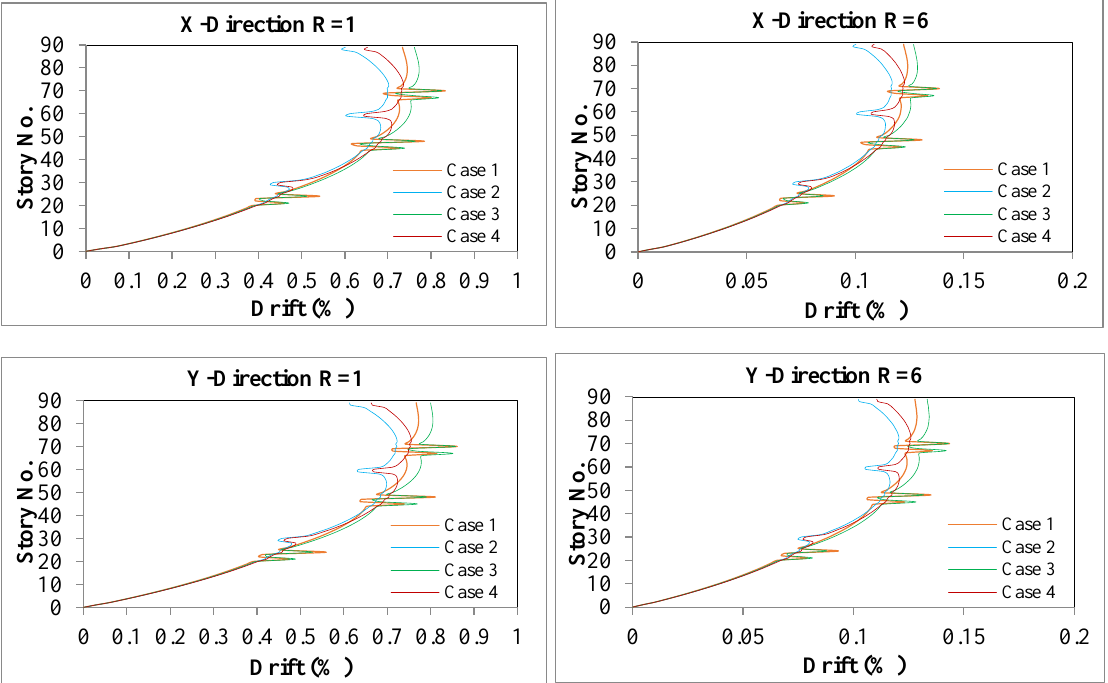
Fig. 8. Story Drift of Studied systems on X and Y direction.